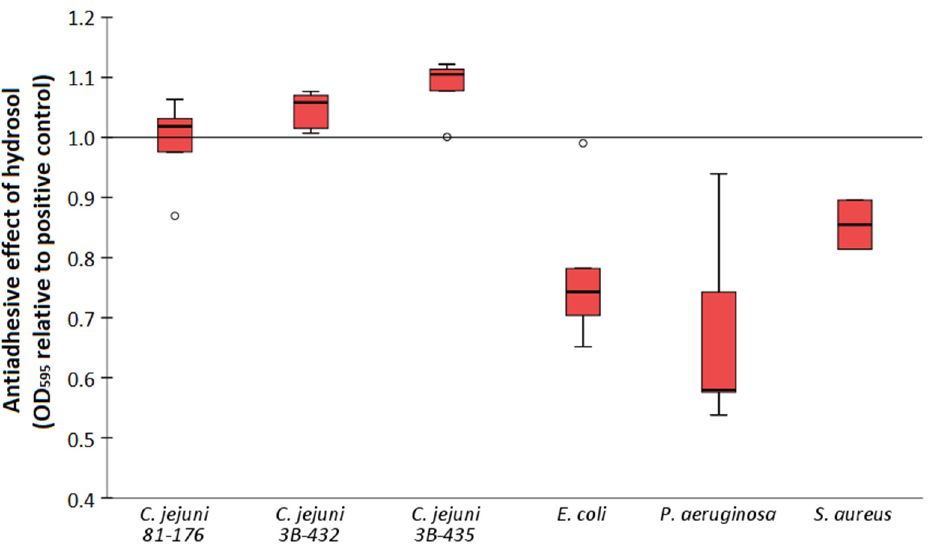
Figure 1. Antiadhesive properties of H. italicum hydrosol expressed as optical density values (OD 595 ) relative to positive control.